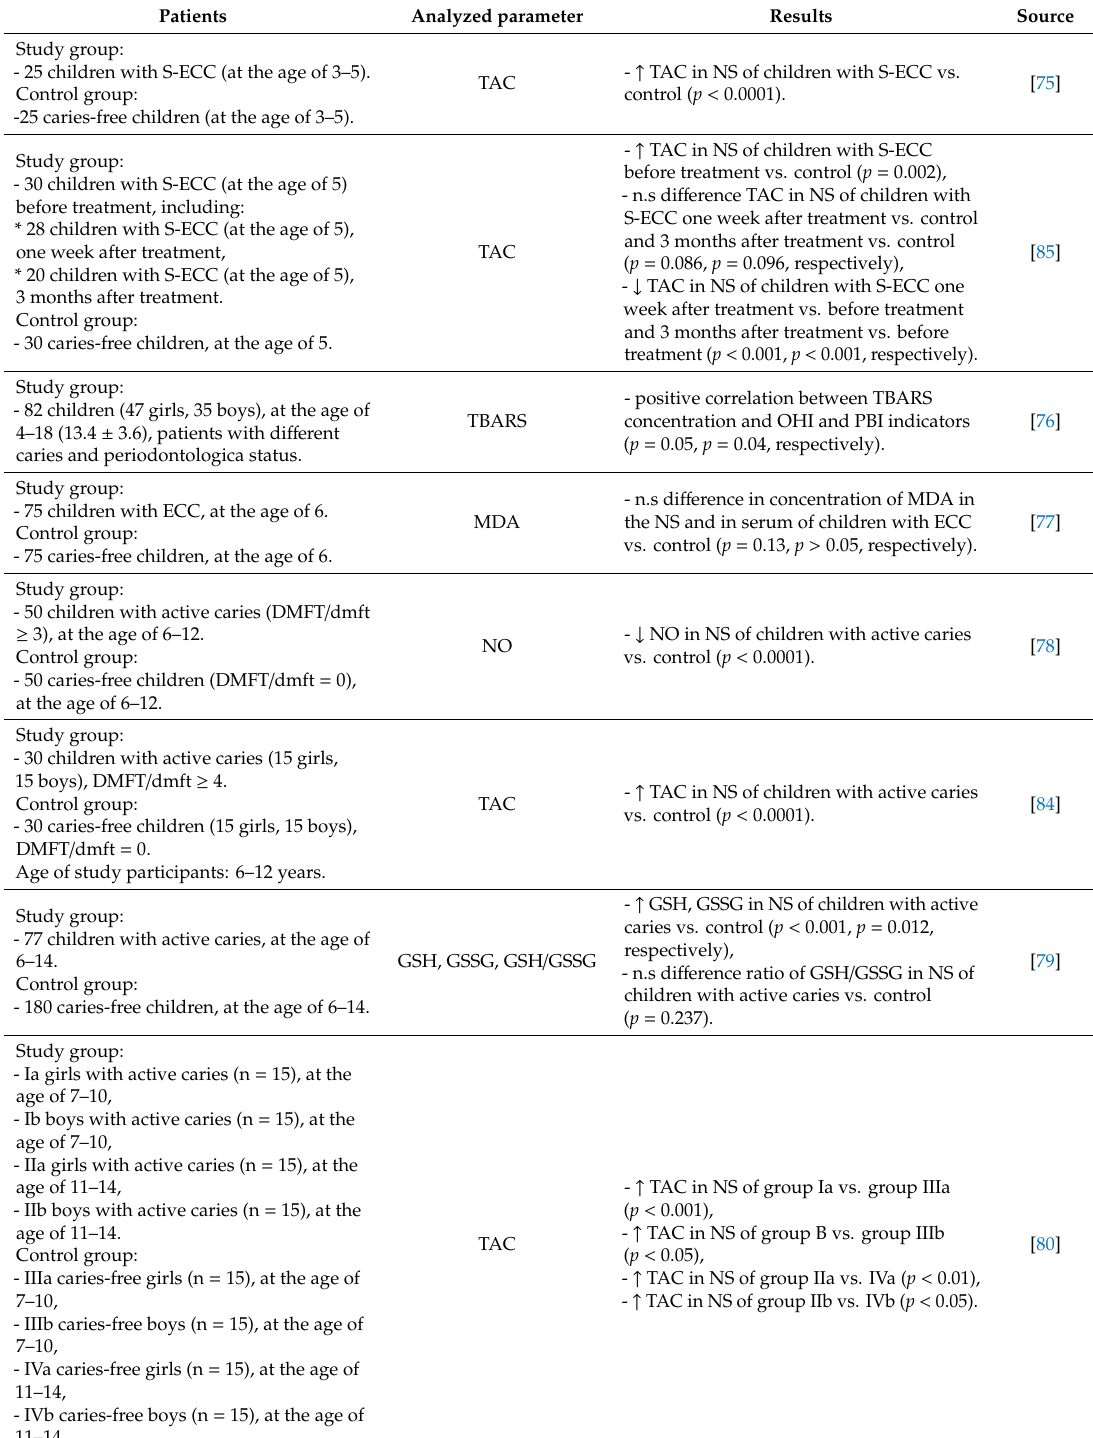
Patients Analyzed parameter Results